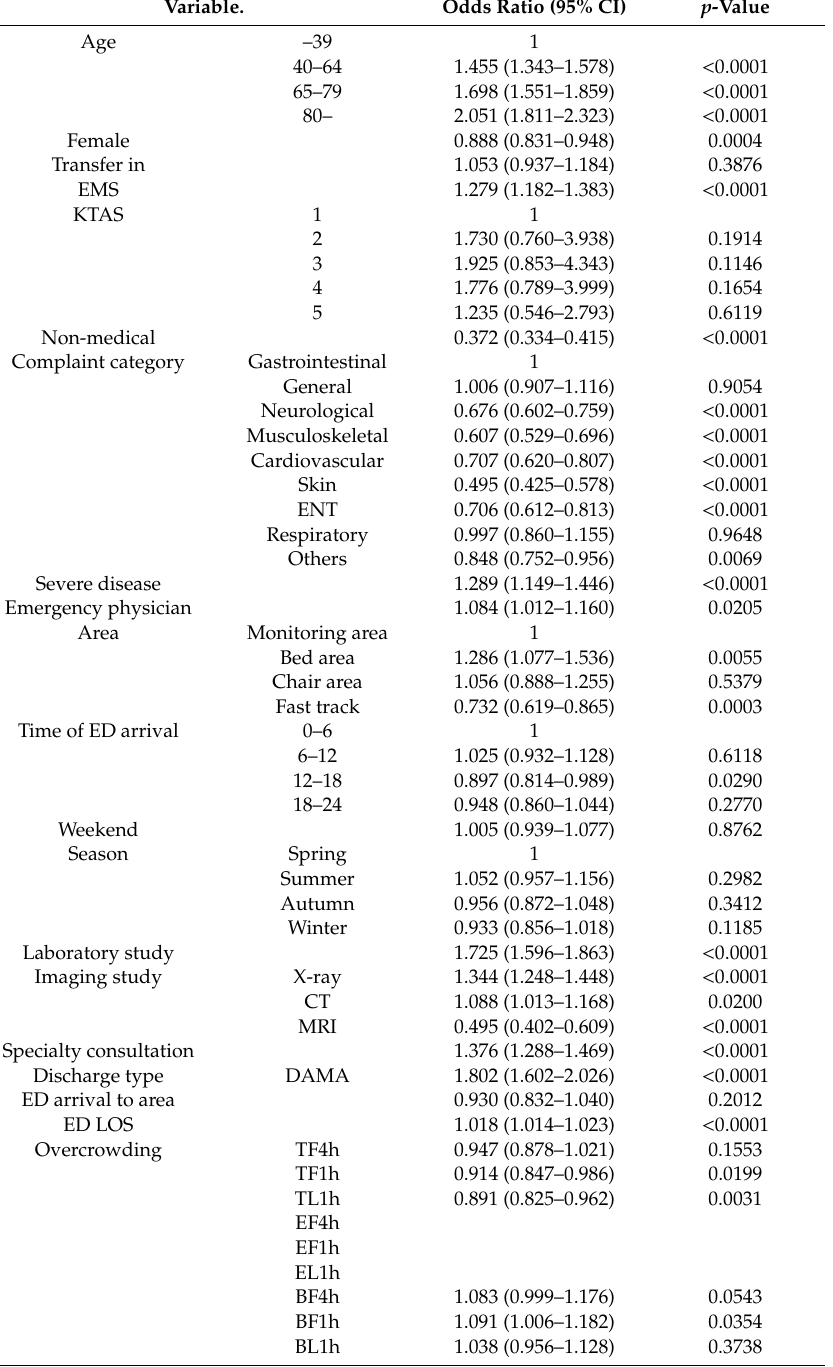
Table A1. Univariable logistic regression of emergency department overcrowding for return visit within 72